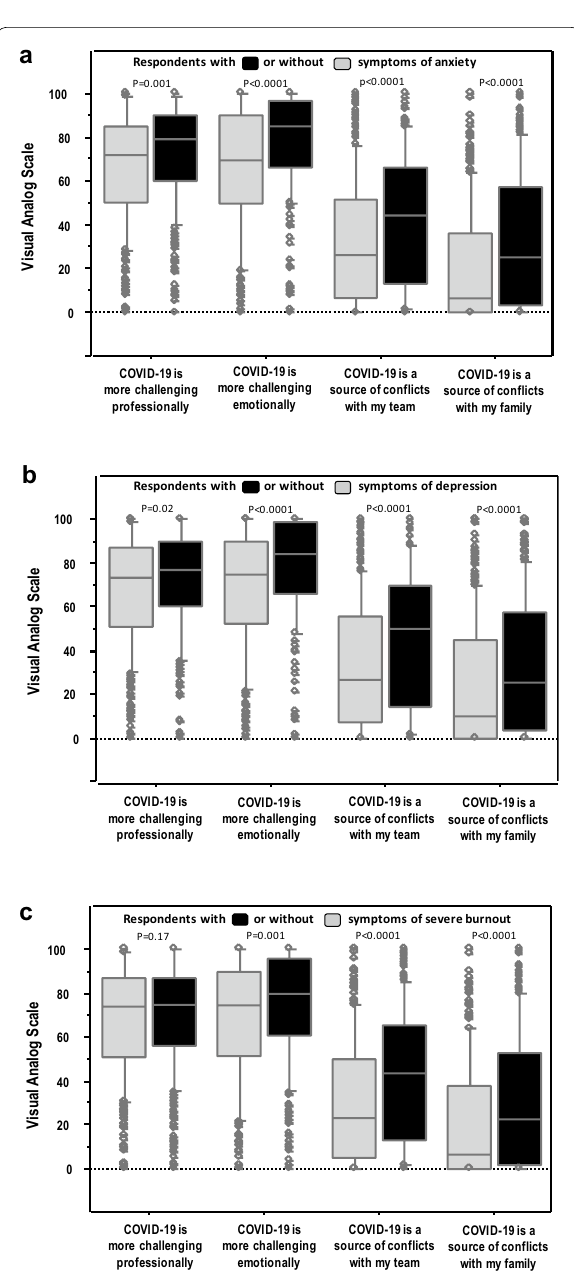
Fig. 3 Physician’s ranking (from 0 [less challenging than non-COVID patients] to 100 [more challenging than non-COVID patients]) of how the pandemic has been a professional and emotional challenge, and whether it was a source of intra-team or intra-family conflict. Results are presented according to the presence of symptoms of anxiety ( a ), the presence of symptoms of depression ( b ), or the presence of symptoms of severe burnout ( c